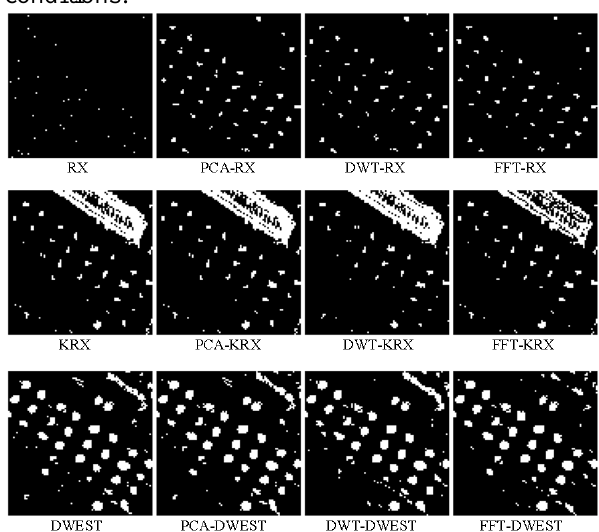
Figure 12. Detection results of algorithms applied to Img- III.